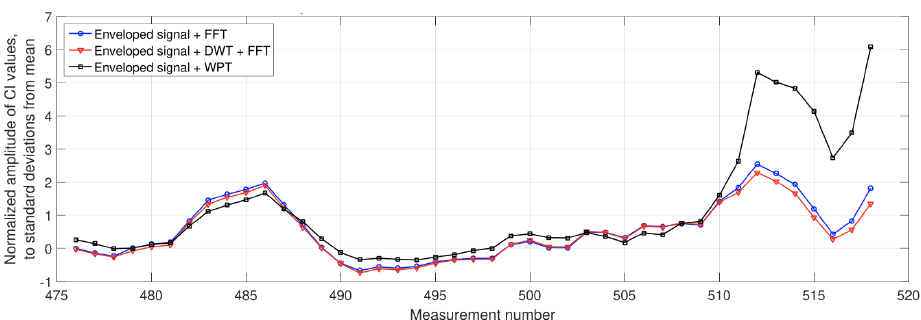
Figure 30. Comparative results between FFT, DWT and WPT methods [117].